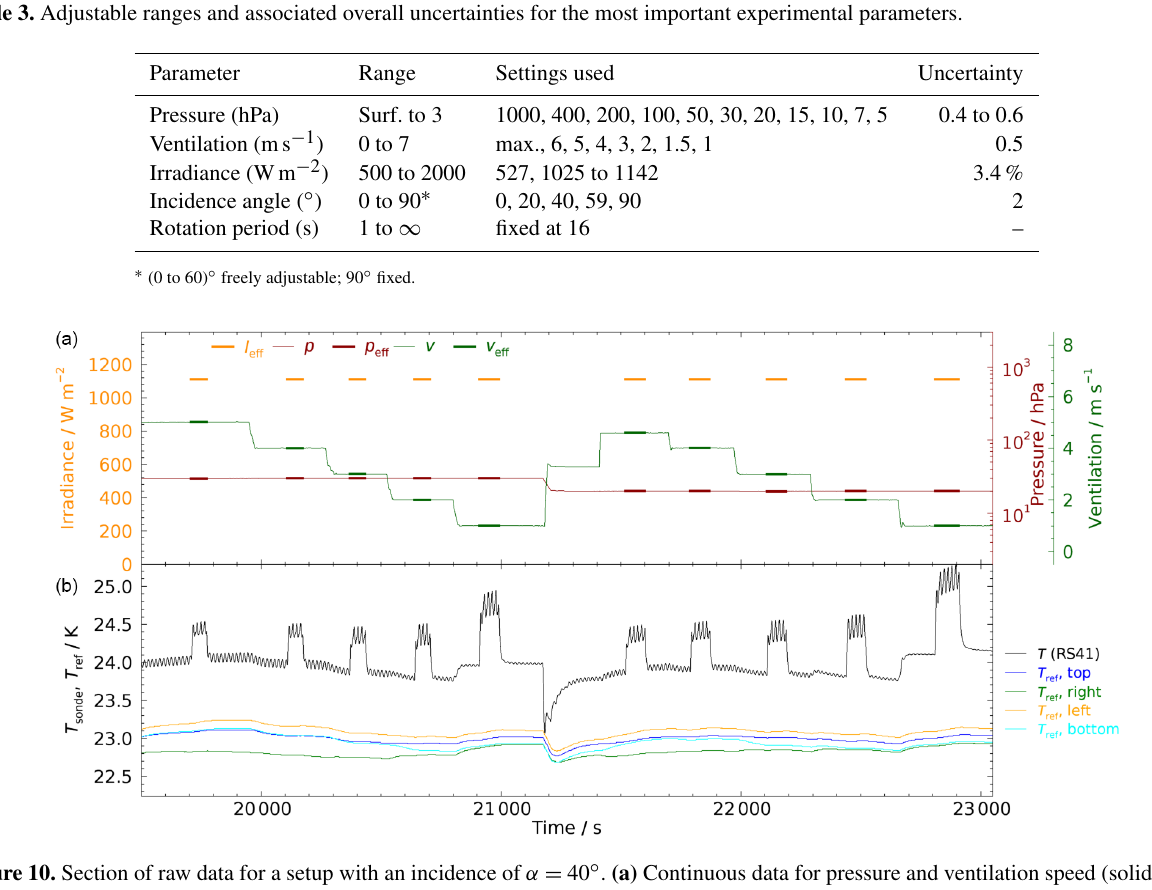
Table 3. Adjustable ranges and associated overall uncertainties for the most important experimental parameters.